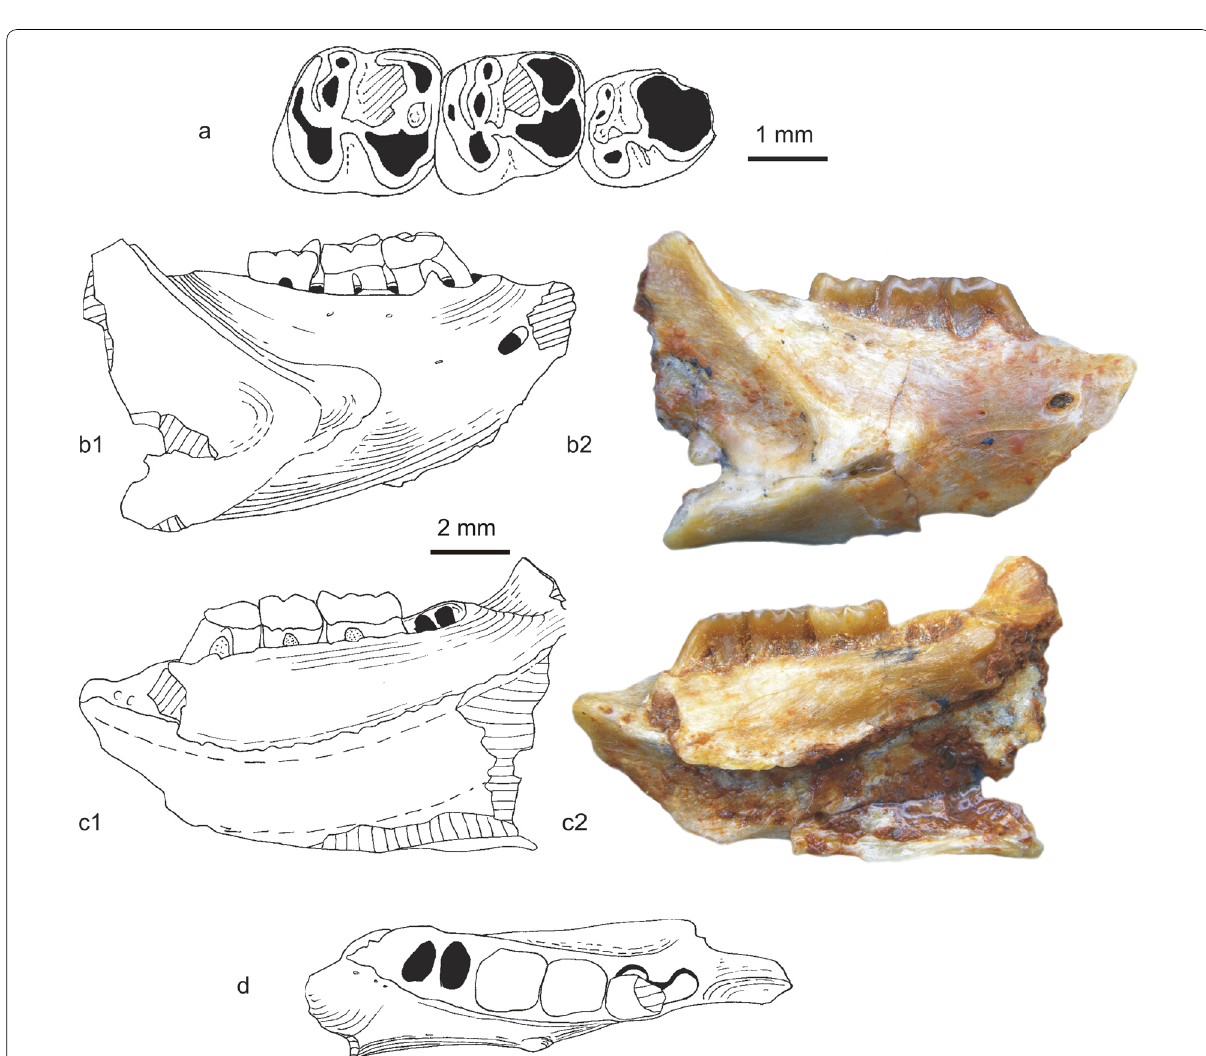
Fig. 24 Protadelomys lugdunensis Hartenberger, 1969, from Laprade (Quercy), LAP 246, right lower jaw; a , occlusal view of the tooth row, p4–m2, worn. Scale bar 1 mm. b , b1 (drawing), b2 (picture): labial side of the dentary = Scale bar 2 =